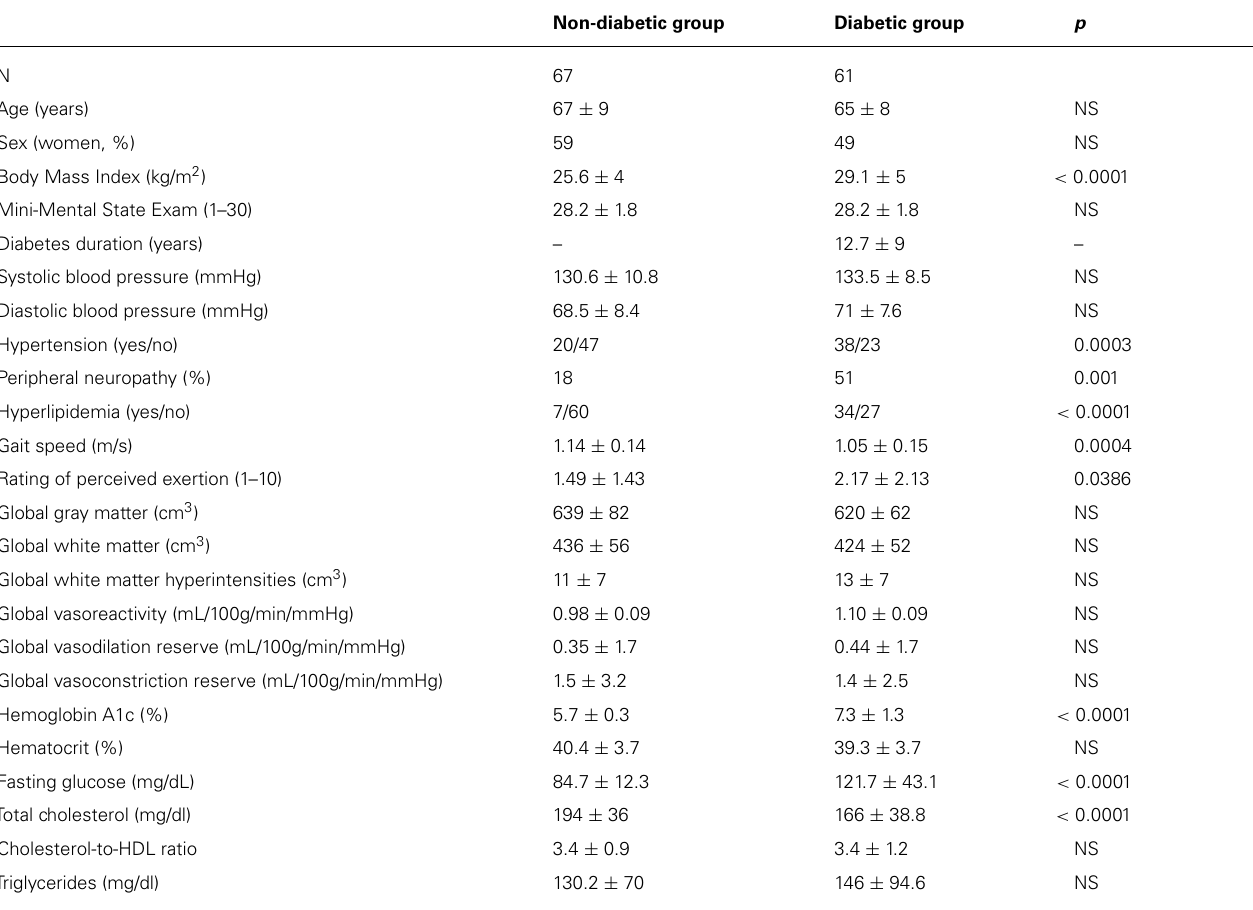
Table 1 | Demographic characteristics of the non-diabetic and diabetic groups.